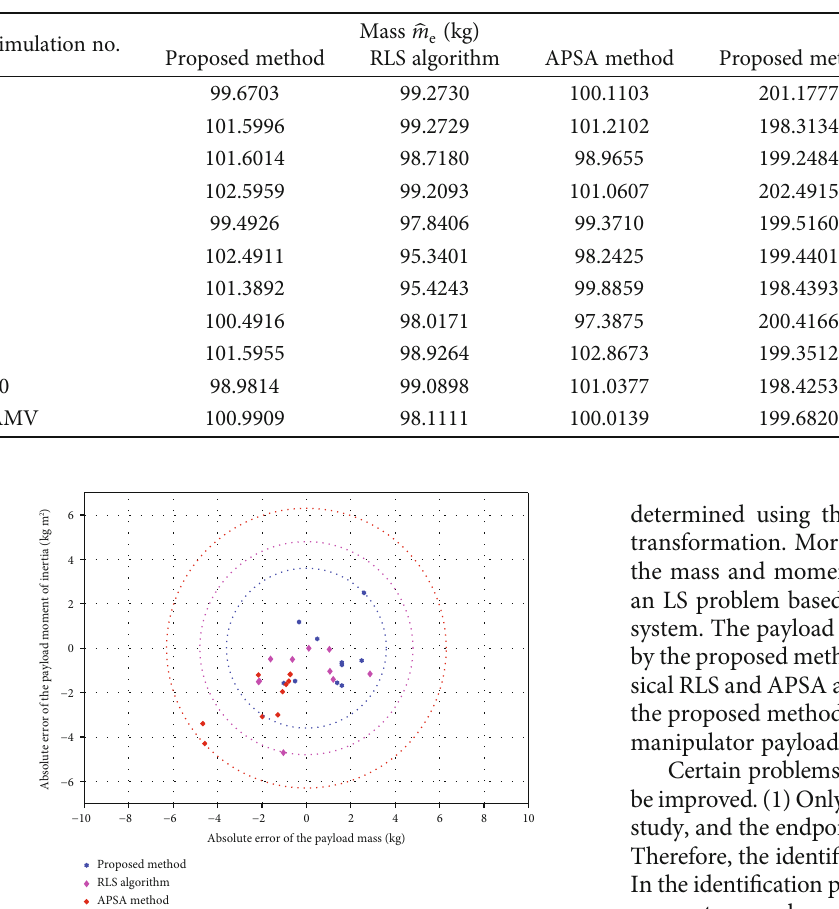
Table 3: Average values of system complex mode shapes ψ between the original and identi fi ed system matrix A